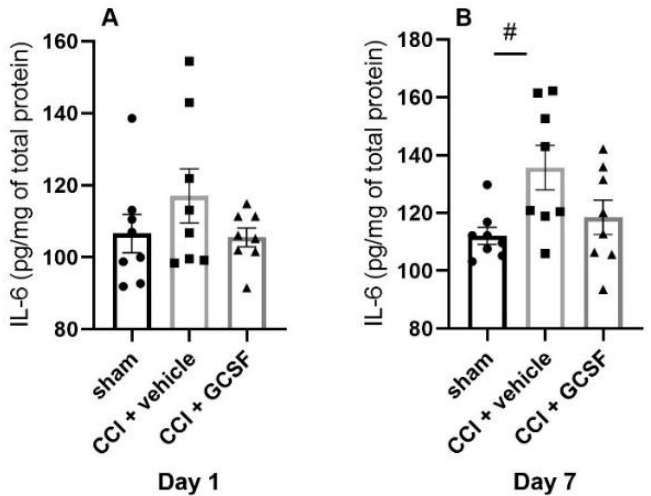
Figure 5. Proinflammatory cytokine IL-6 expression in the DRGs of sham-operated rats, vehicle-treated CCI rats, and GCSF-treated CCI rats. The vehicle-treated CCI rats exhibited significantly higher IL-6 levels in the DRGs than the sham-operated rats on the 7th day after nerve injury ( B ). The GCSF-treated CCI rats exhibited lower IL-6 levels in the DRGs than the vehicle-treated CCI rats on the 1st and 7th days after nerve injury ( A , B ). However, the di ff erence between the groups did not reach statistical significance (one-way ANOVA, post hoc Tukey’s test or Kruskal–Wallis, post hoc Mann–Whitney rank-sum test, if appropriate; Day 1 and 7: n = 8 per group; # p < 0.05: vehicle-treated rats compared to sham-operated